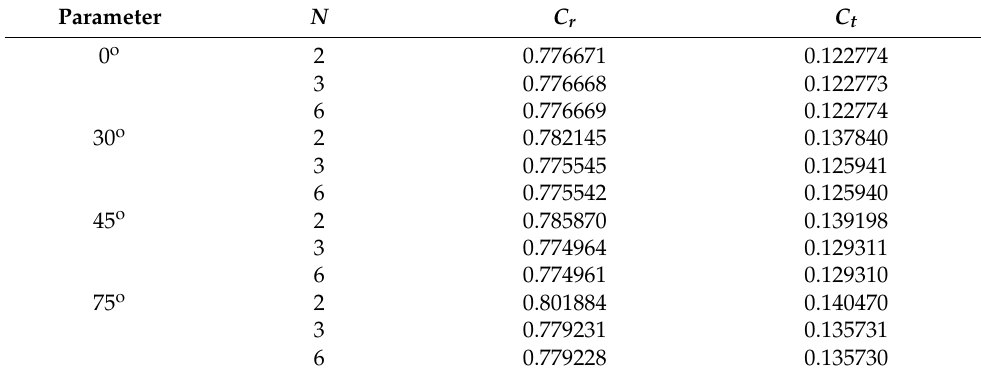
Table 1. Convergence analysis.